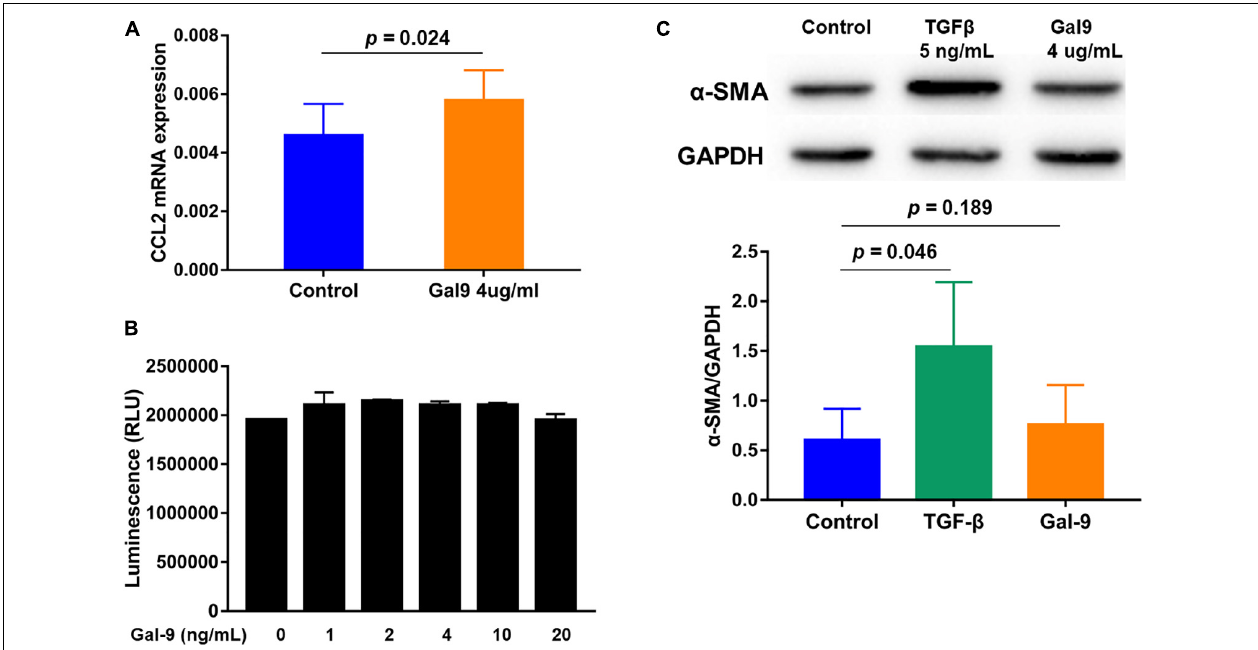
FIGURE 5 | Effects of galectin-9 (Gal-9) on the function of MRC-5 fibroblasts. (A) Monocyte chemoattractant protein-1 (CCL2) mRNA levels in Gal-9-treated MRC-5 fibroblasts compared to the control group. (B) Proliferation of MRC-5 fibroblasts stimulated with Gal-9 for 24 h. (C) α -smooth muscle actin (SMA) protein expression of MRC-5 fibroblasts treated with transforming growth factor- β (TGF- β ) or Gal-9. The graphs show the mean ± standard deviation of and each graph determined from at least three independent experiments. GAPDH, glyceraldehyde-3-phosphate